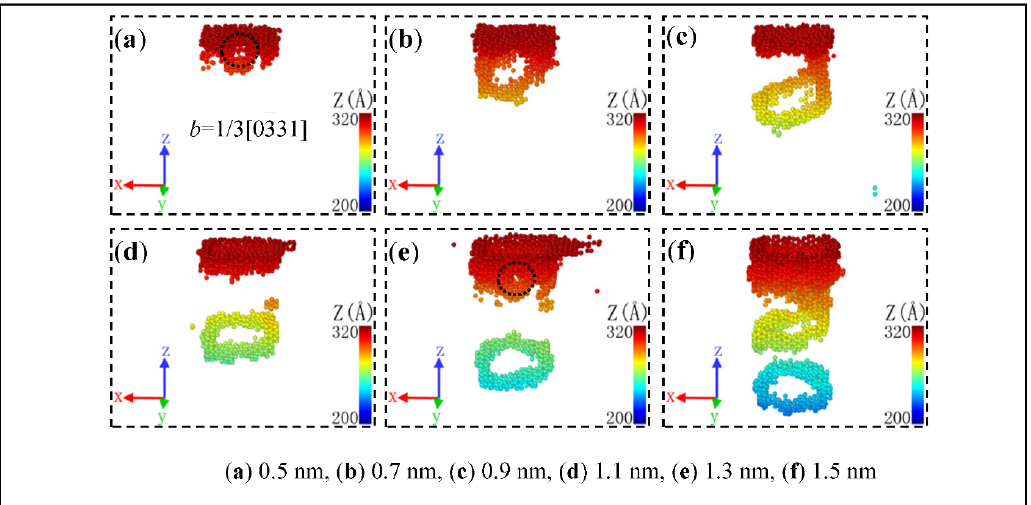
—— 0) crystal surface with different indentation depths. Figure 4. Deformation process of 6H-SiC (2110) crystal surface with different indentation